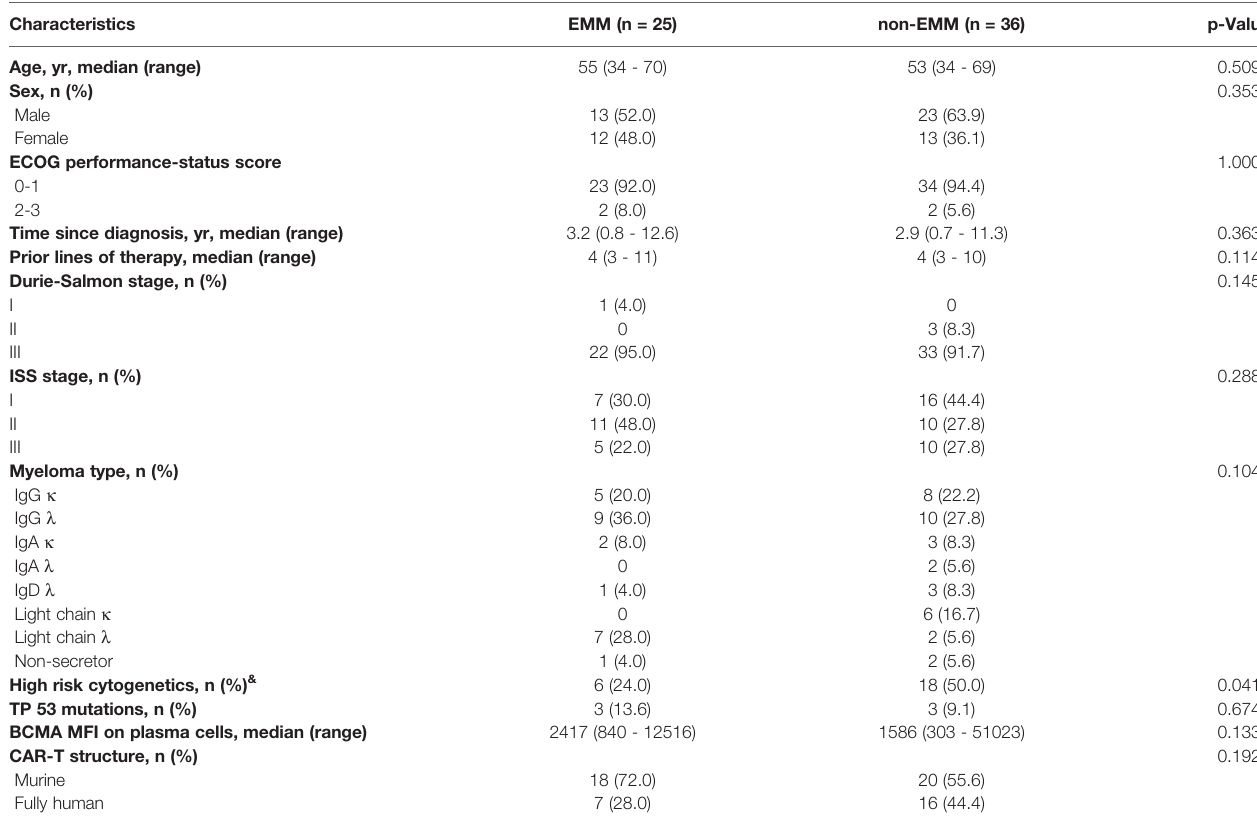
TABLE 2 | Comparison of baseline characteristics between EMM patients and non-EMM patients in the two clinical trials conducted in our center. Characteristics